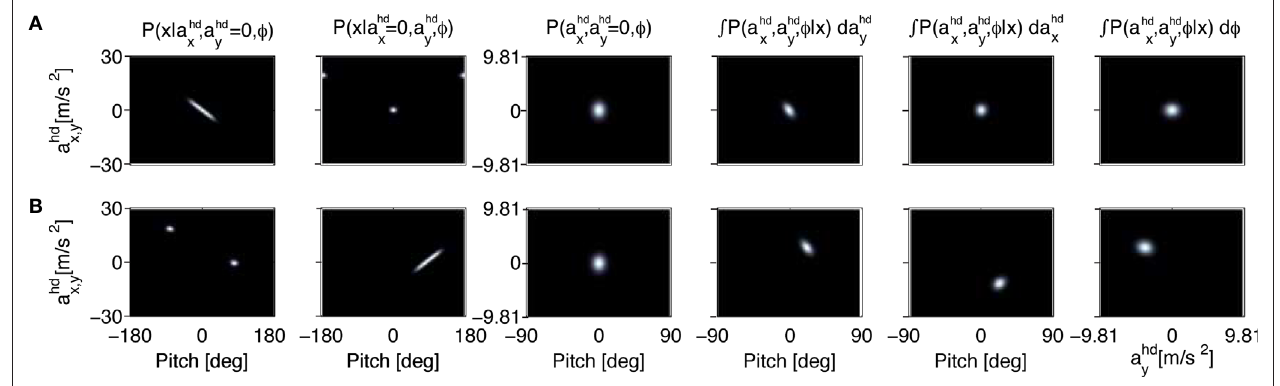
angle. The last three panels show the posteriors with different variables being integrated over. (B) Panel order is the same as in (A) , but for a sensory stimulus x corresponding to the supine position with φ = 0. .9 π All priors are Gaussians 2 with zero mean and σ = σ = 1 and σ φ = 0.1. For the sensory noise we set σ = x y n